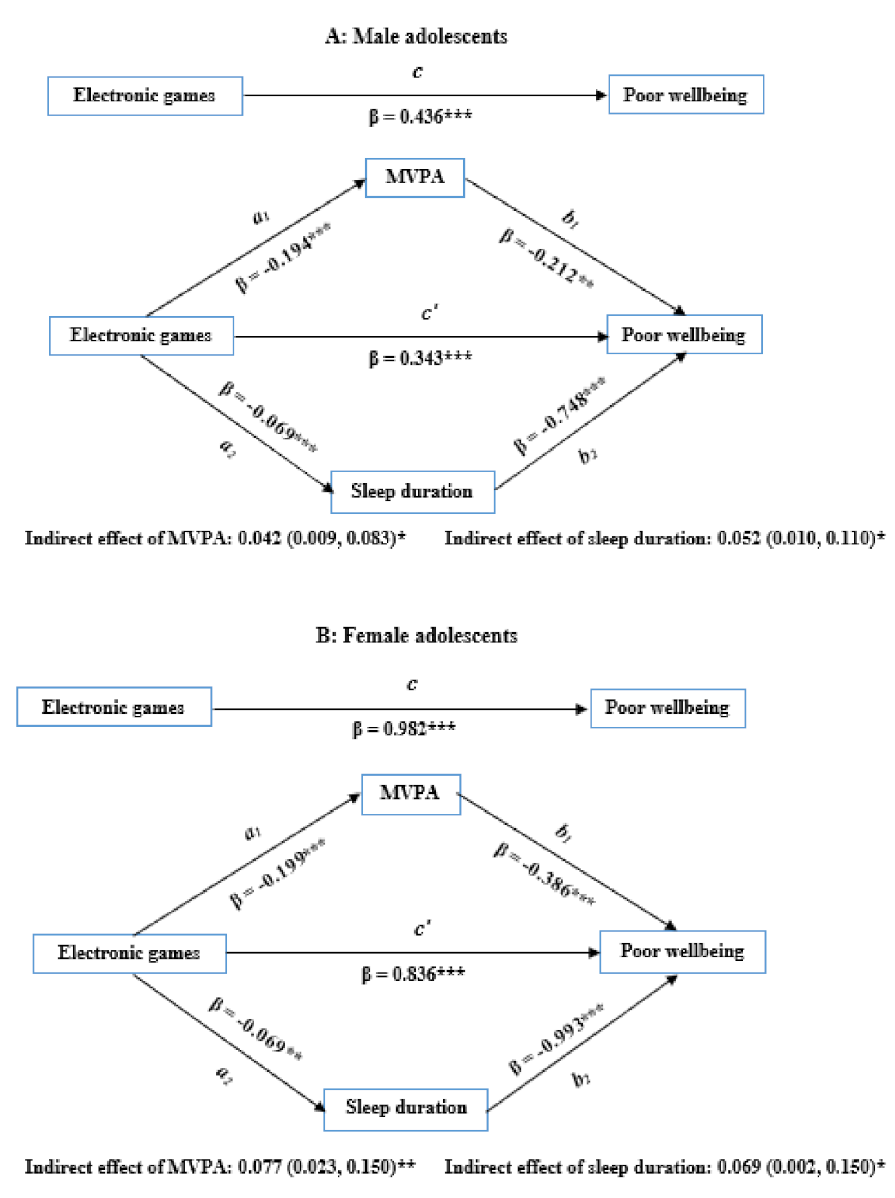
Figure 1. Models of moderate to vigorous physical activity (MVPA) frequency and sleep duration mediating the association between time playing electronic games and psychological wellbeing of ( A ) male and ( B ) female adolescents,